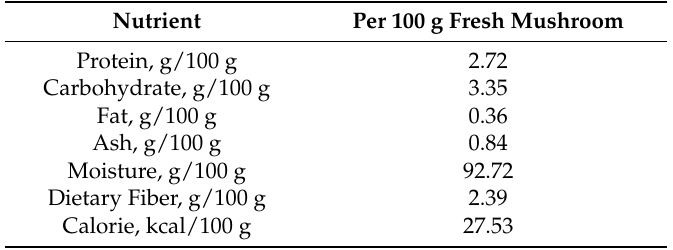
Table 1. Analysis of white button mushroom nutrient